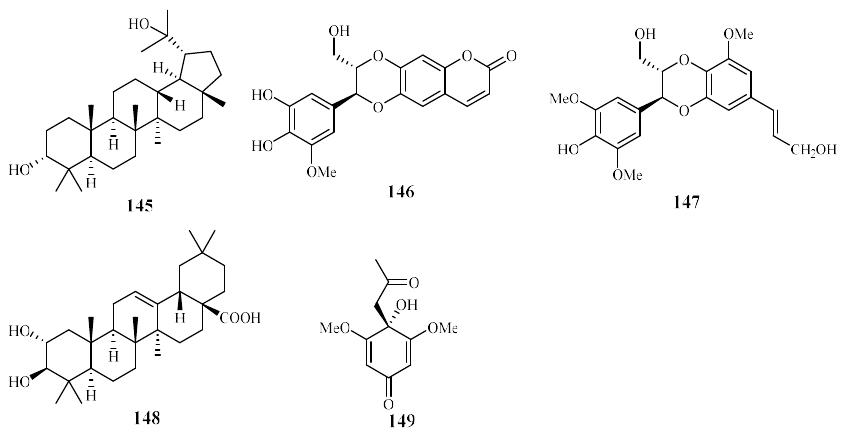
Figure 33. Compounds from a Tiliaceae plant.